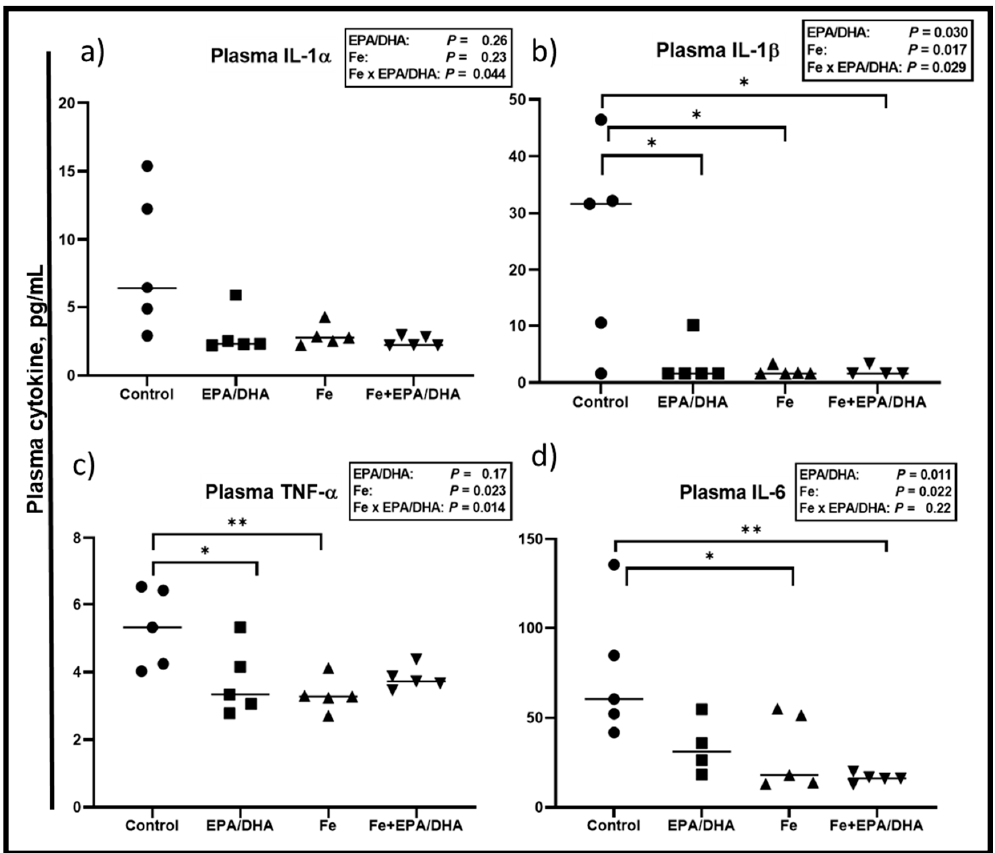
Figure 6. Plasma cytokine levels after providing Mtb -infected mice with control, EPA / DHA, Fe, or Fe + EPA / DHA diets for three weeks, including ( a ) IL-1 α , ( b ) IL-1 β , ( c ) TNF- α , and ( d ) IL-6. Results repeated in two experiments, data shown for one experiment ( n = 5 per group). Two-way ANOVA was used to test e ff ects of EPA / DHA (control & Fe vs. EPA / DHA & Fe + EPA / DHA), Fe (control & EPA / DHA vs. Fe & Fe + EPA / DHA), and Fe × EPA / DHA interactions. One-way ANOVA followed